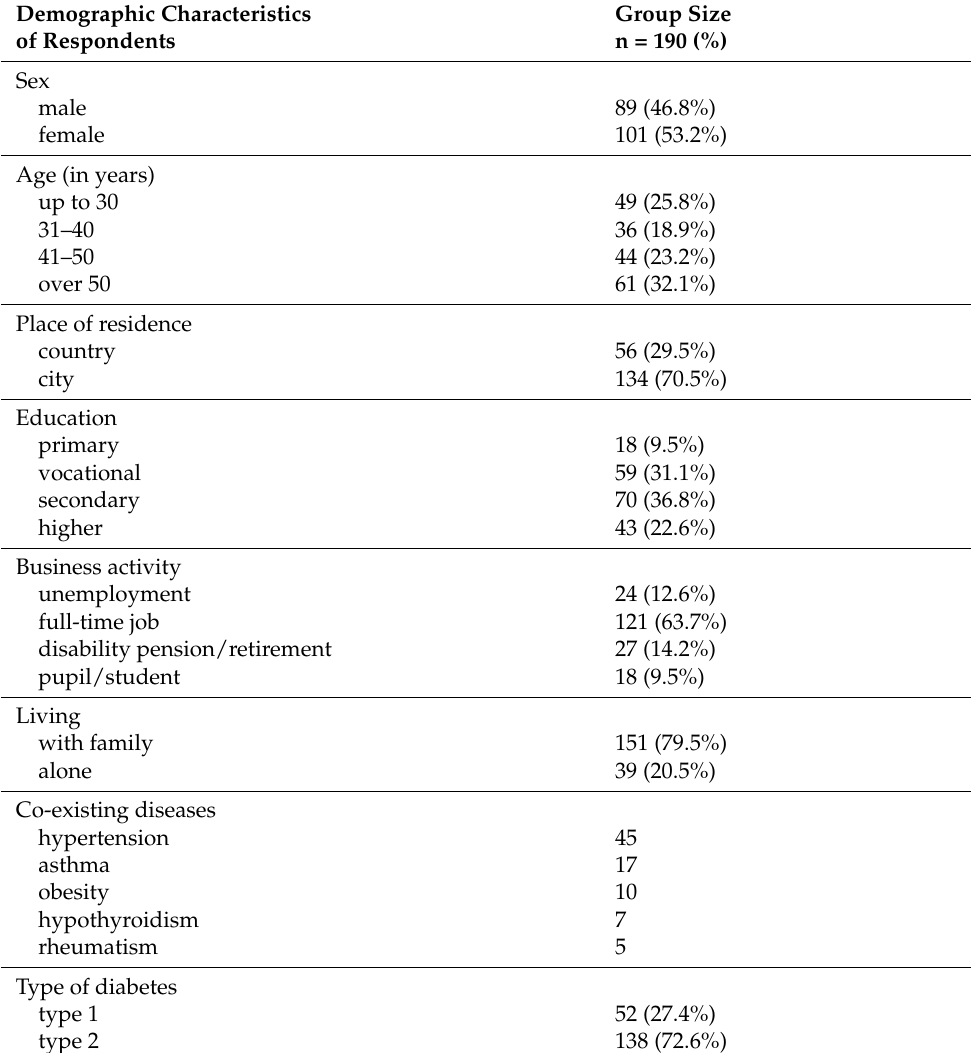
Table 1. The general characteristics of the study population. Demographic Characteristics